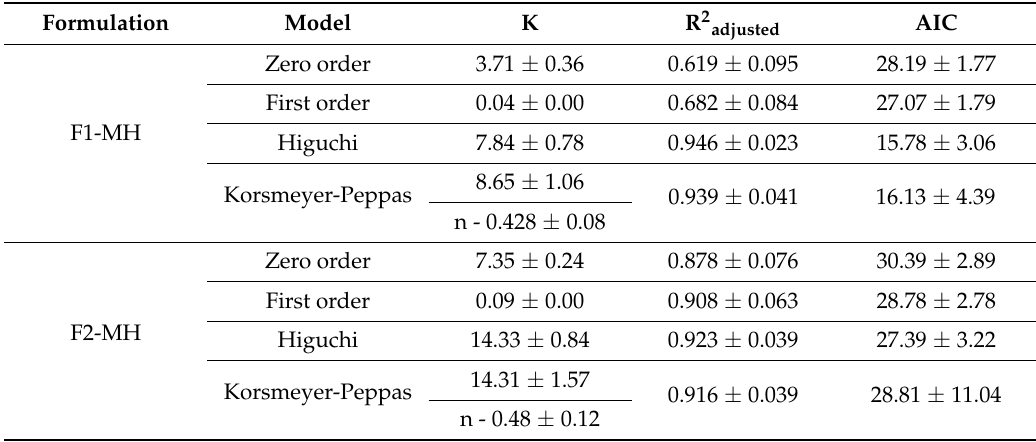
Table 4. Kinetic parameters obtained after fitting the release data from the formulations to different release models (mean ± SD, n =